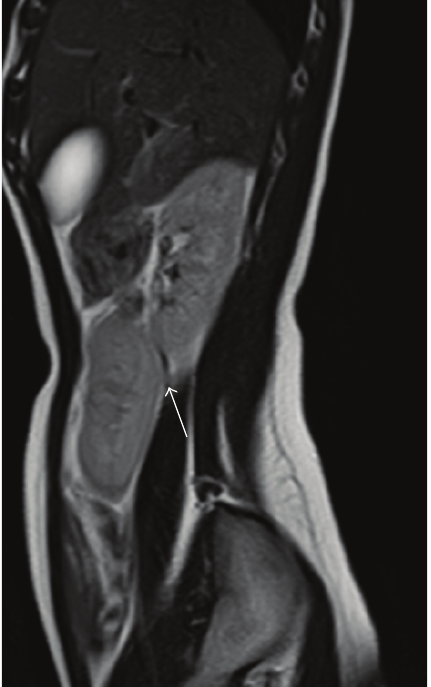
Figure 1: 11-year-old adolescent female with left-to-right crossed renal ectopia. Sagittal RM scan, showing a clear plane of separation between the two kidneys (white arrow) and each kidney, having its own Gerota’s fascia.